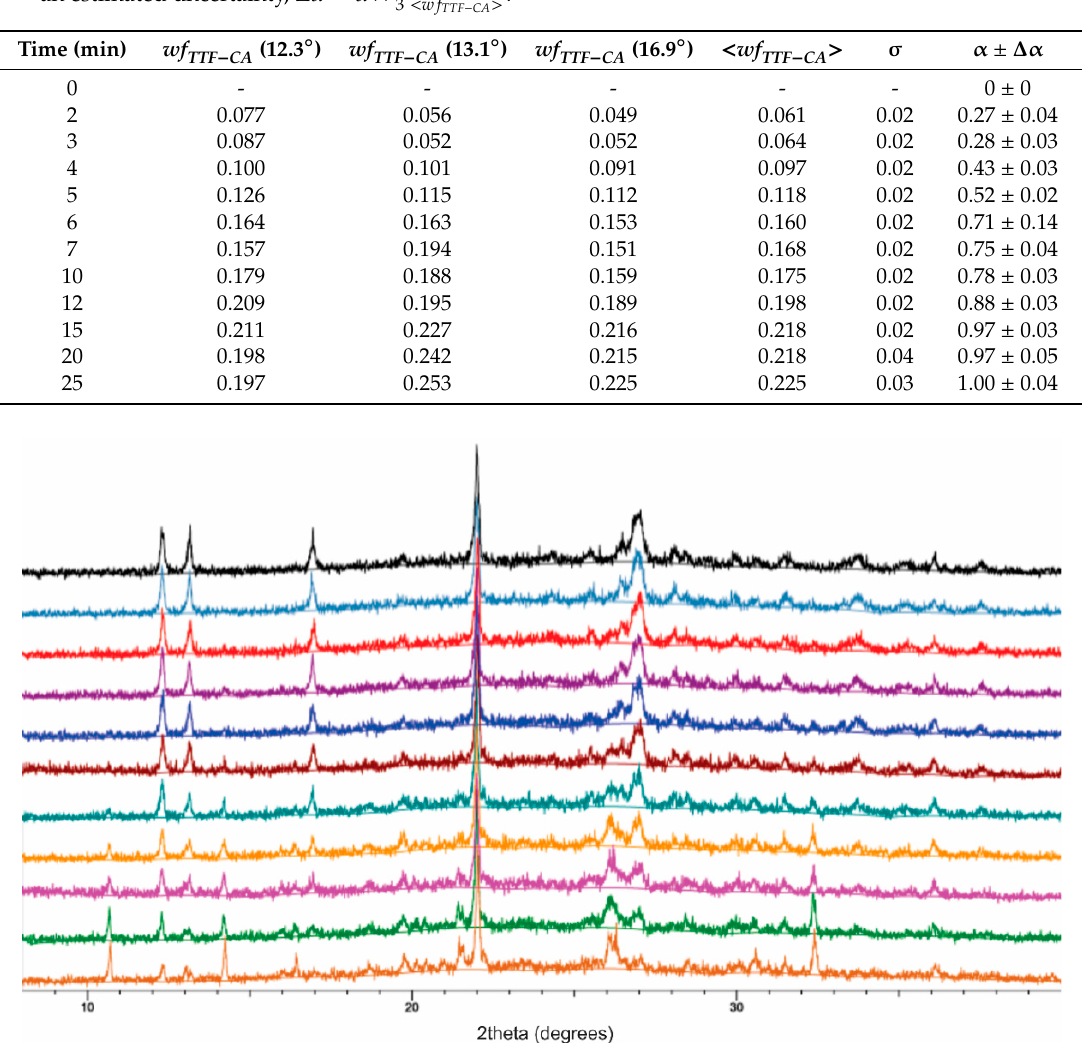
Table 2. Reaction times; TTF-CA weight fractions ( wf TTF − CA ) averaged from three consecutive XRPD scans using the calibration curves based in the di ff raction peaks at 12.3 ◦ , 13.1 ◦ and 16.9 ◦ , respectively; the average of the nine wf TTF − CA values ( < wf TTF − CA > ); its standard deviation ( σ ); the calculated α and σ an estimated uncertainty, ∆ α = α × . 3 < wf TTF − CA >